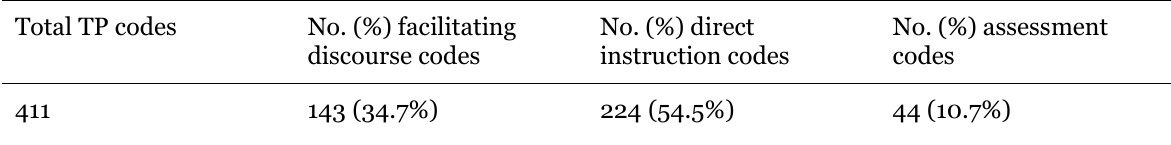
Instructor Teaching Presence Codes